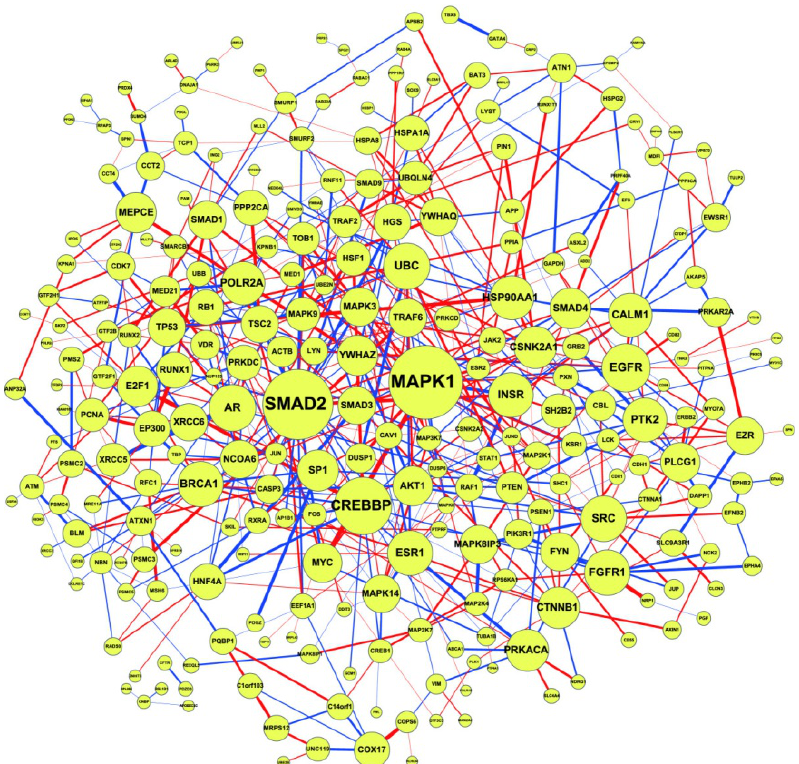
Figure 6. The difference between CPAN and NPAN obtained from Equation (2.20) for network-based biomarkers for lung cancer. The significance of proteins (indicated by circle size) to the network-based marker is dependent on their CRVs in Equation (2.21), which are listed in Table